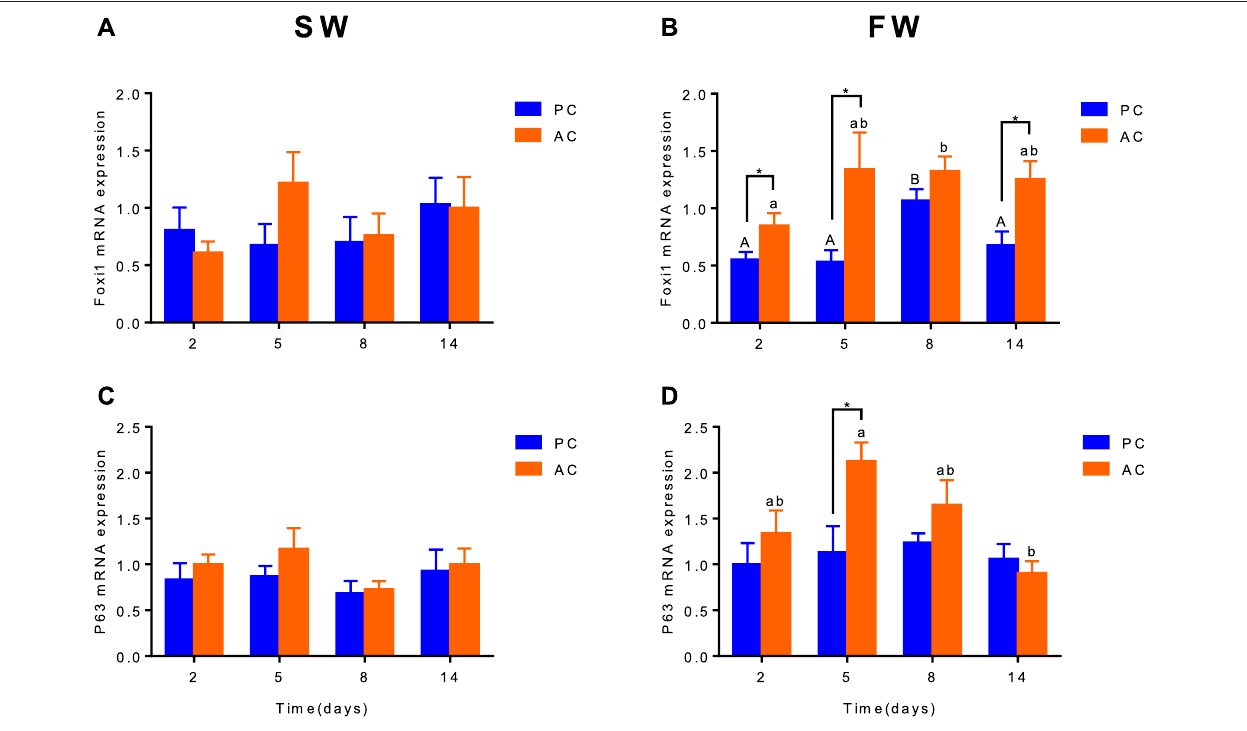
FIGURE 4 | The branchial gene expression of Foxi1 (A,B) and P63 (C,D) in olive fl ounder with passive coping style (PC) and active coping style (AC) either in seawater[SW, (A,C) ],oraftertransfertofreshwater[FW, (C,D) ].Dataaremean±SEM( n =6).Anasterisksigni fi esasigni fi cantdifferencebetweenthePCandACgroups at each time point ( p < 0.05). Different letters denote a signi fi cant difference across time within the same coping style group ( p < 0.05).